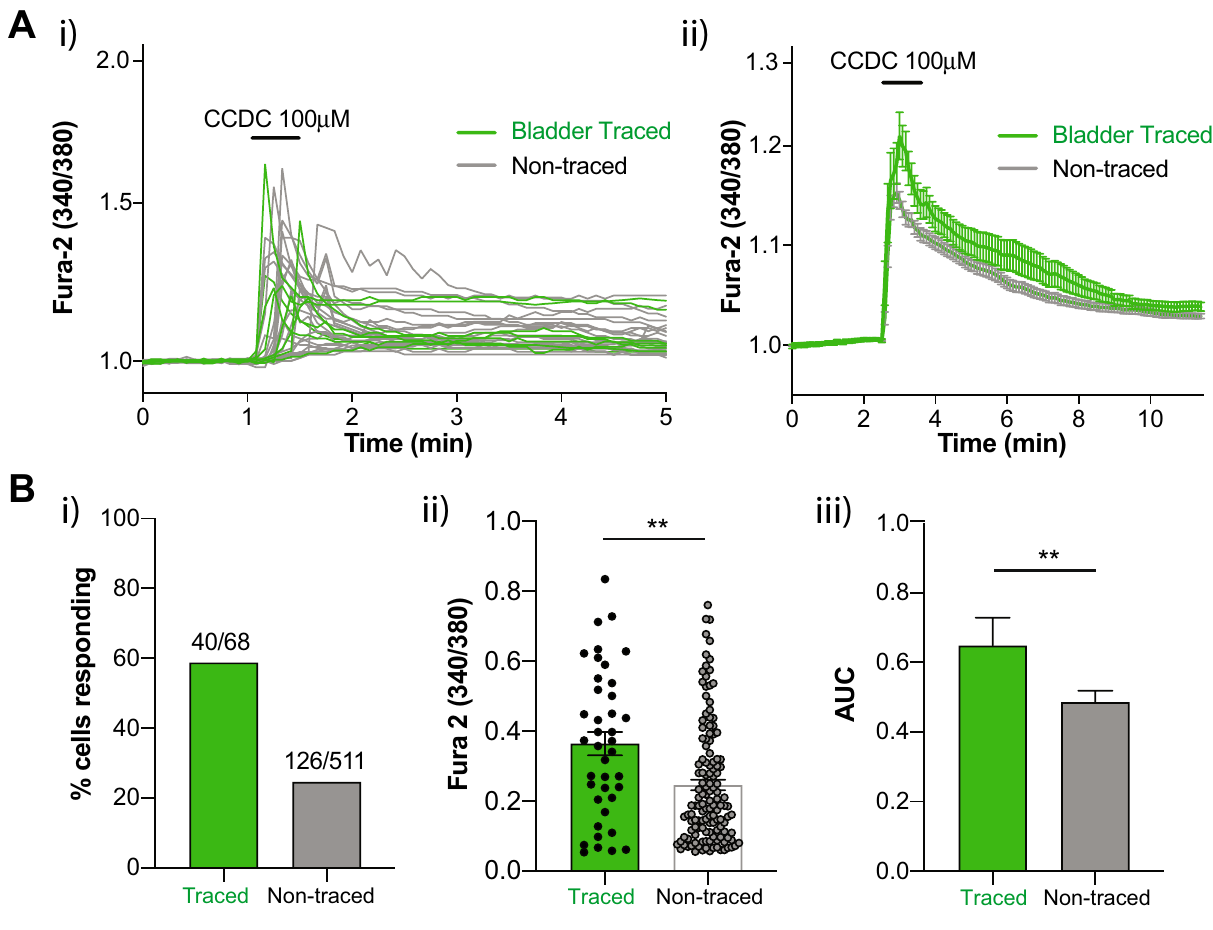
Figure 6. In vitro activation of TGR5 in primary DRG neurons results in increased intracellular Ca 2+ . ( A ) Live cell calcium imaging was performed on retrogradely traced, isolated LS DRG neurons from wild-type mice to measure intracellular Ca 2+ changes in response to direct CCDC (100 µM) application. ( i ) An example experiment showing bladder traced (green) and non-traced (grey) DRG neurons from a single coverslip, with each line representing a single neuron over time and an increase in the Fura-2 fluorescence ratio (340/380) indicating an increase in intracellular Ca 2+ from baseline normalised to a ratio of 1. ( ii ) Mean ± SEM of intracellular Ca 2+ responses to CCDC (100 μM) in traced (n = 40) and non-traced (n = 126) neurons. ( B ) ( i ) 58.82% of bladder traced neurons (40 out of 68; N = 7) responded to CCDC application with an increase in intracellular Ca 2+ , compared to only 24.65% of non-traced neurons (126 out of 511). The response to CCDC for traced and non-traced neurons showed ( ii ) a significantly higher maximum peak (**** P < 0.0001) and ( iii ) a significantly larger area under the curve (AUC, ** P < 0.01) in bladder-innervating DRG neurons compared to non-traced DRG